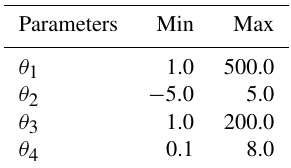
Table 1. Prior ranges of parameters in the GR4J hydrological model.